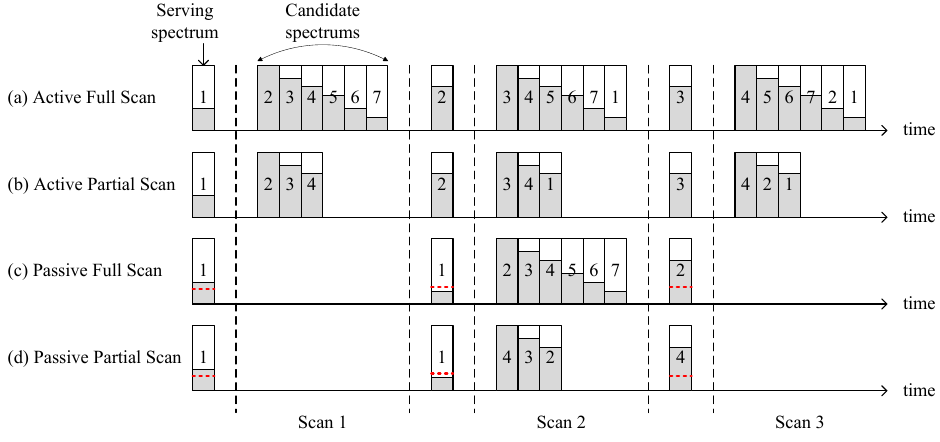
Figure 5. An example of a fast spectrum scanning